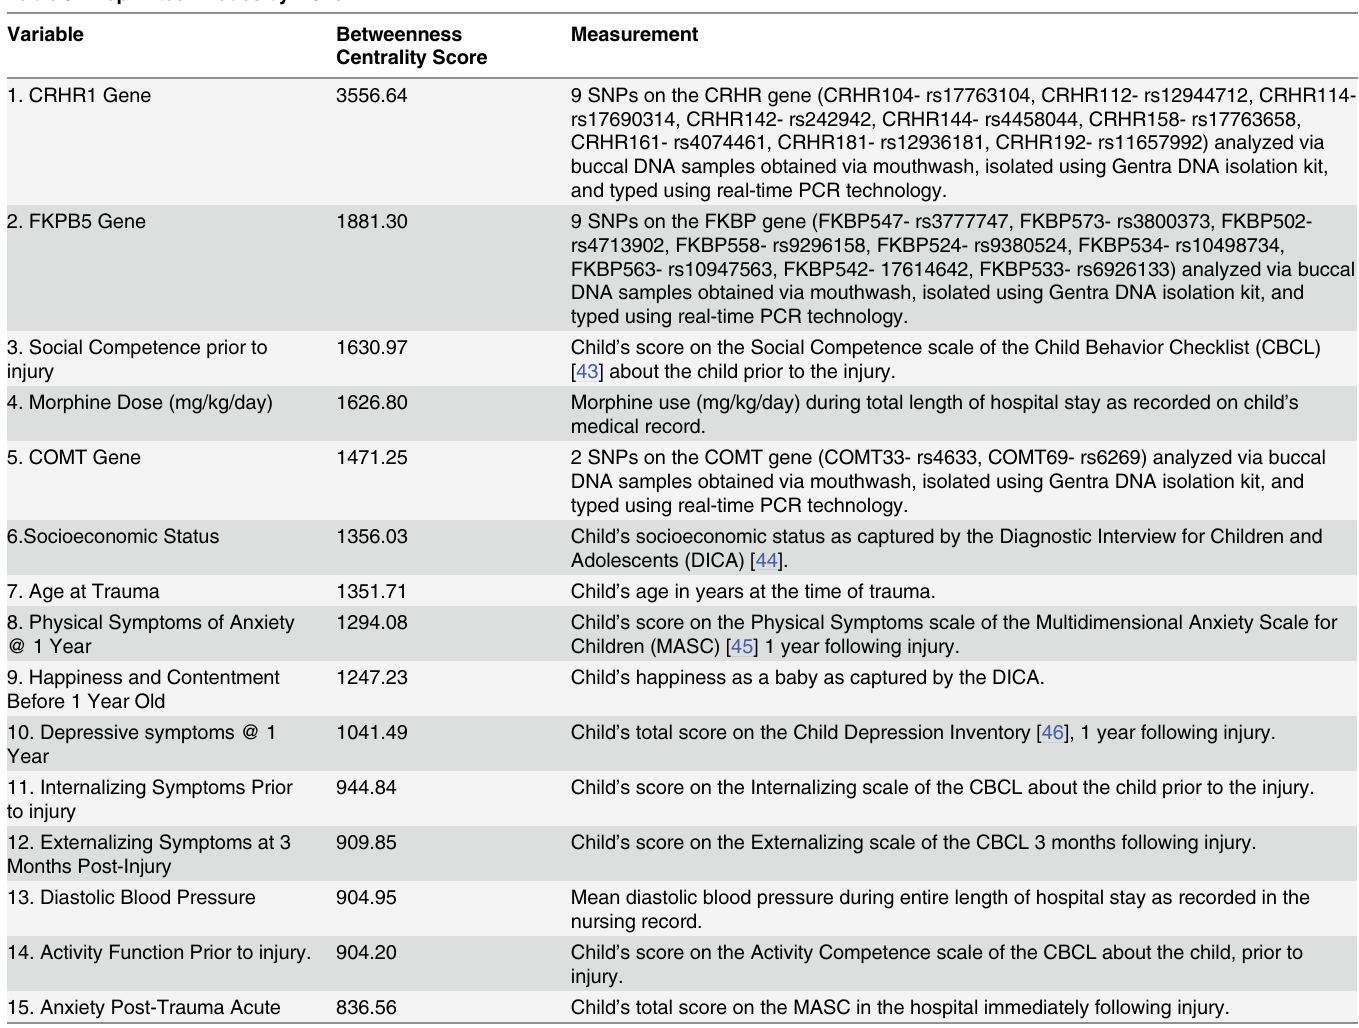
Table 3. Top Fifteen Nodes by BC rank.